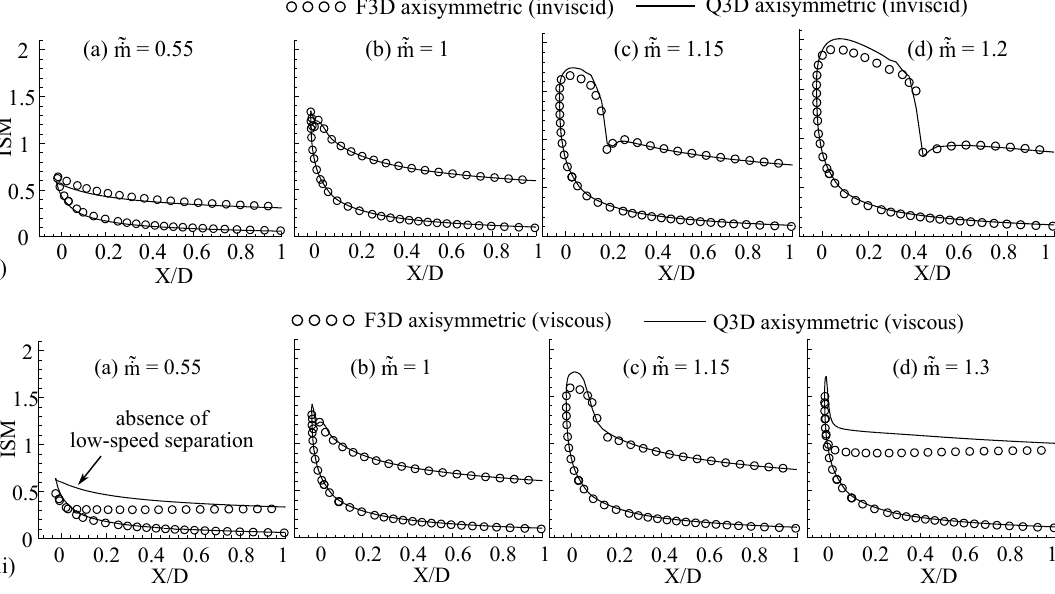
Figure 11. Variation of ISM with axial distance for F3D axisymmetric and Q3D cases with ( i ) inviscid BC and ( ii ) viscous no-slip BC on the intake lip.